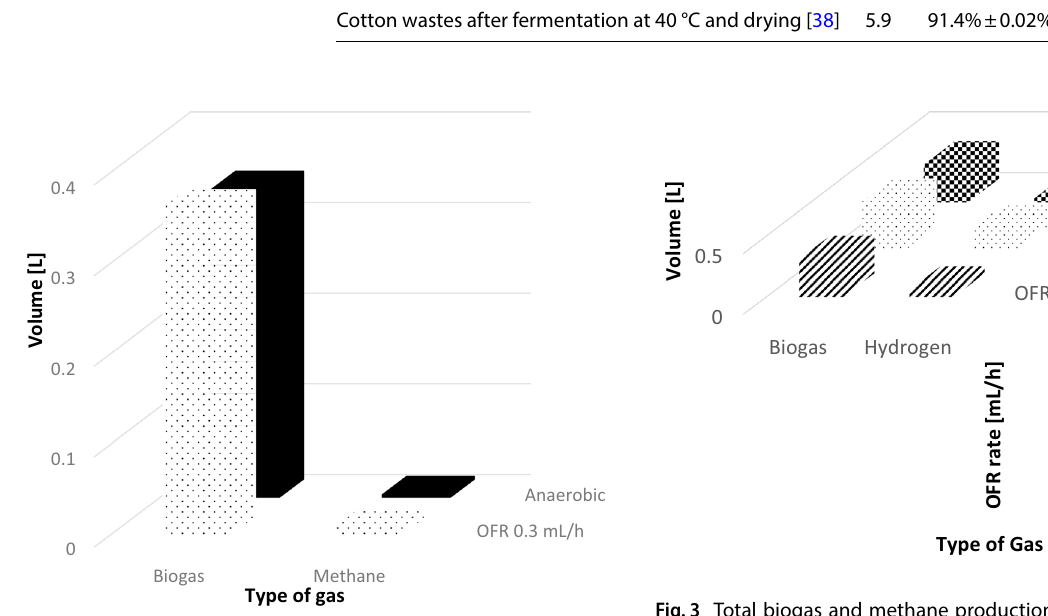
Fig. 2 Total biogas and hydrogen production obtained during fer- mentation process stimulated by pretreated inoculum, at T = 40 °C and OFR (oxygen flow rate) 0.3, 0.8 and 1 mL/h